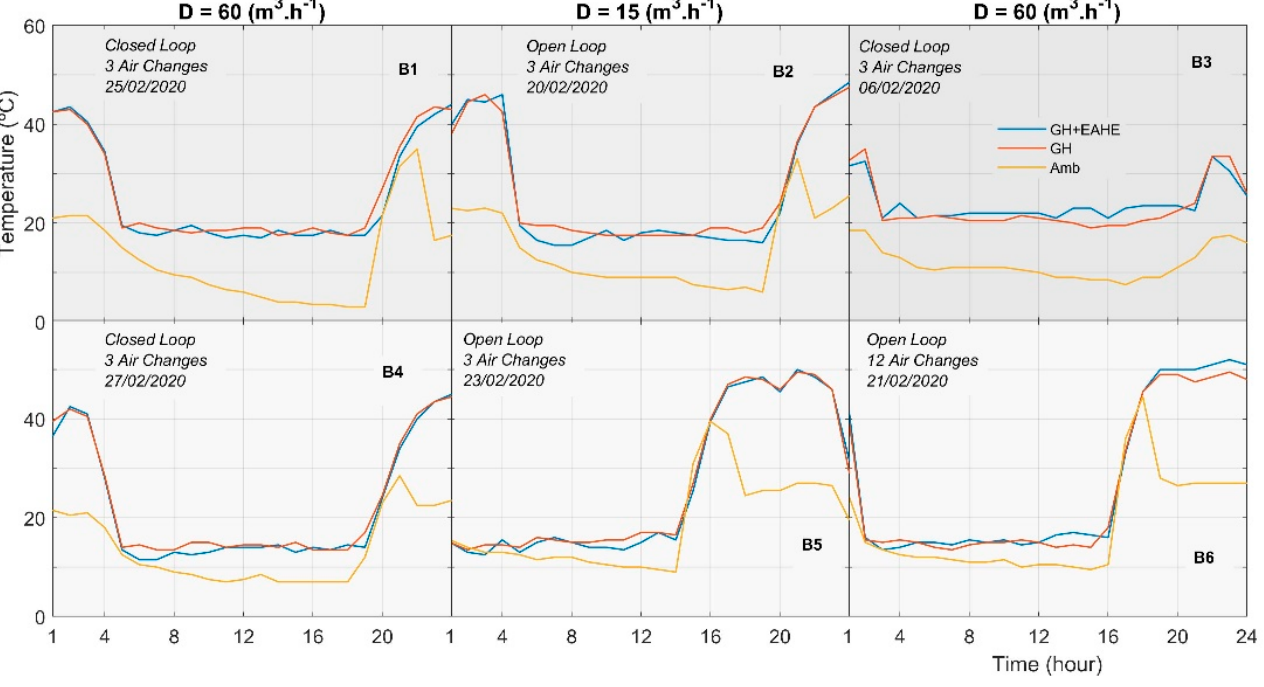
Figure 5. GHs air temperature variation during the experience’s periods (heater device: On).